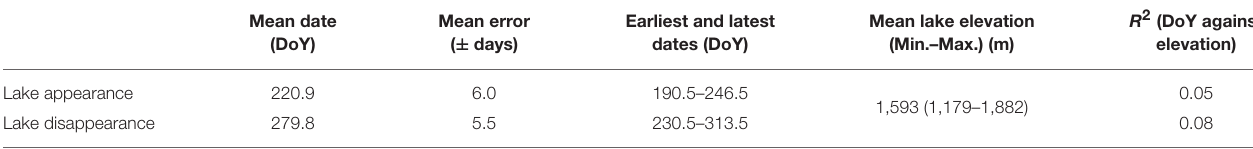
TABLE 4 | Statistics from the subsurface lake appearance and disappearance detections from the Sentinel-1 data. DoY refers to day of year (in